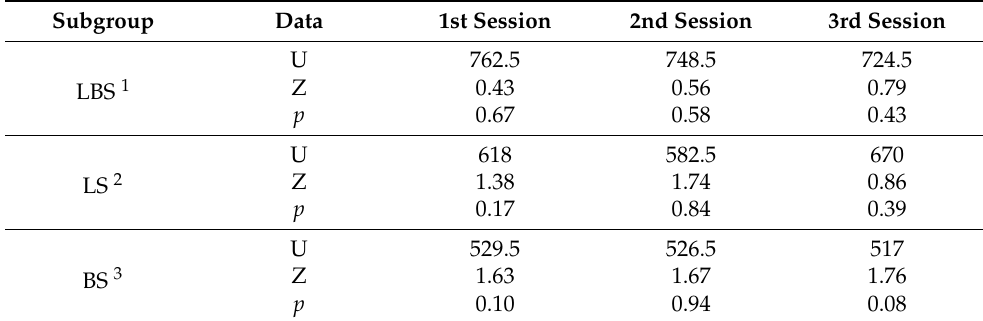
Table 8. Mann-Whitney U-test between male and female TGMD-3